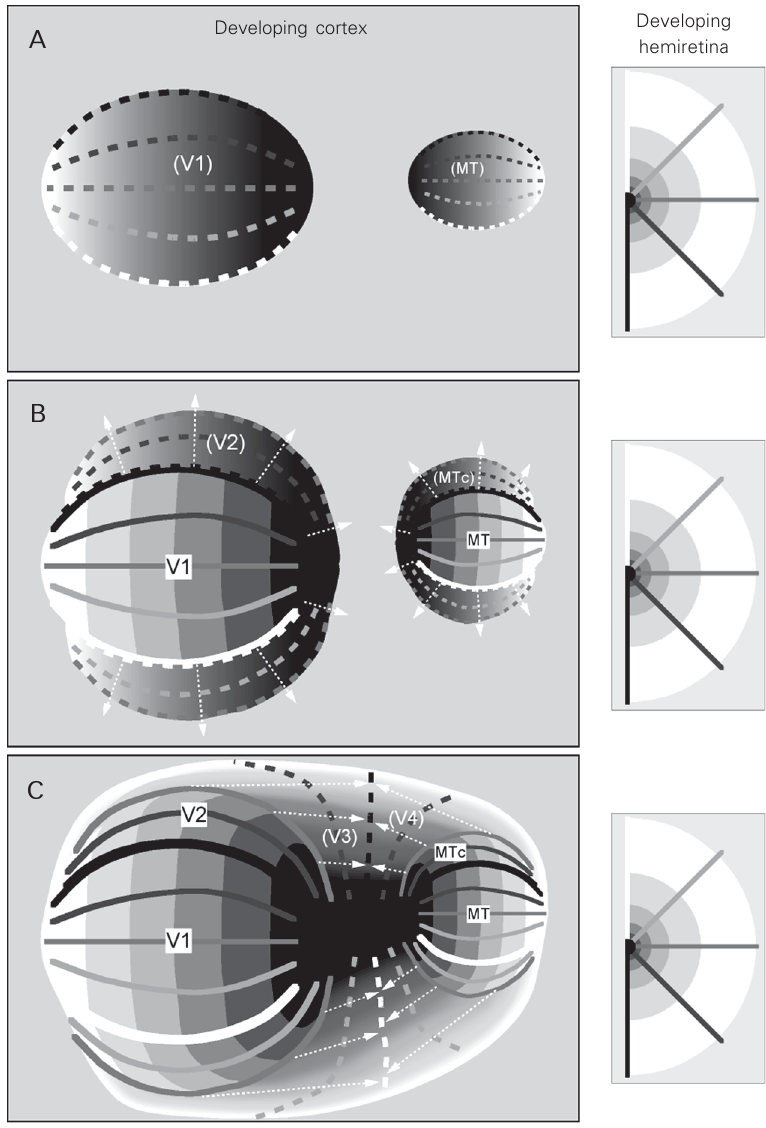
Figure 4. Schematic view of the development of visuotopic maps according to the “molecular anchors” hypothesis. In these diagrams, dashed lines and continuous grey scale gradients indicate regions undergoing early stages of the process of visuotopic map formation. A , Two primary visual maps (corresponding to adult visual primary (V1) and middle temporal (MT) areas, the only first-order representations in the adult brain) are specified early in development, either by gradual distributions of cell surface chemoattrac- tant/chemorepellent molecules (40) or by spatiotemporal patterning of the afferent projec- tion (44). B , With the V1 and MT maps defined, the visuotopic maps in adjacent areas (V2 and MTc) start to self-organise around these “anchors”. Two rules guide this process: 1) the receptive fields of neurones in adjacent columns must overlap, and 2) the gradient of representation does not revert within a given area (arrows). This ensures that the same part of the visual field is not represented more than once in a given area, except along its boundaries. C , At a later stage of development, additional maps (e.g., V3 and V4) self- organise, using the established maps of V2 and MTc as “anchors”. Throughout pre- and post-natal development, activity-dependent mechanisms allow the fine-tuning of the